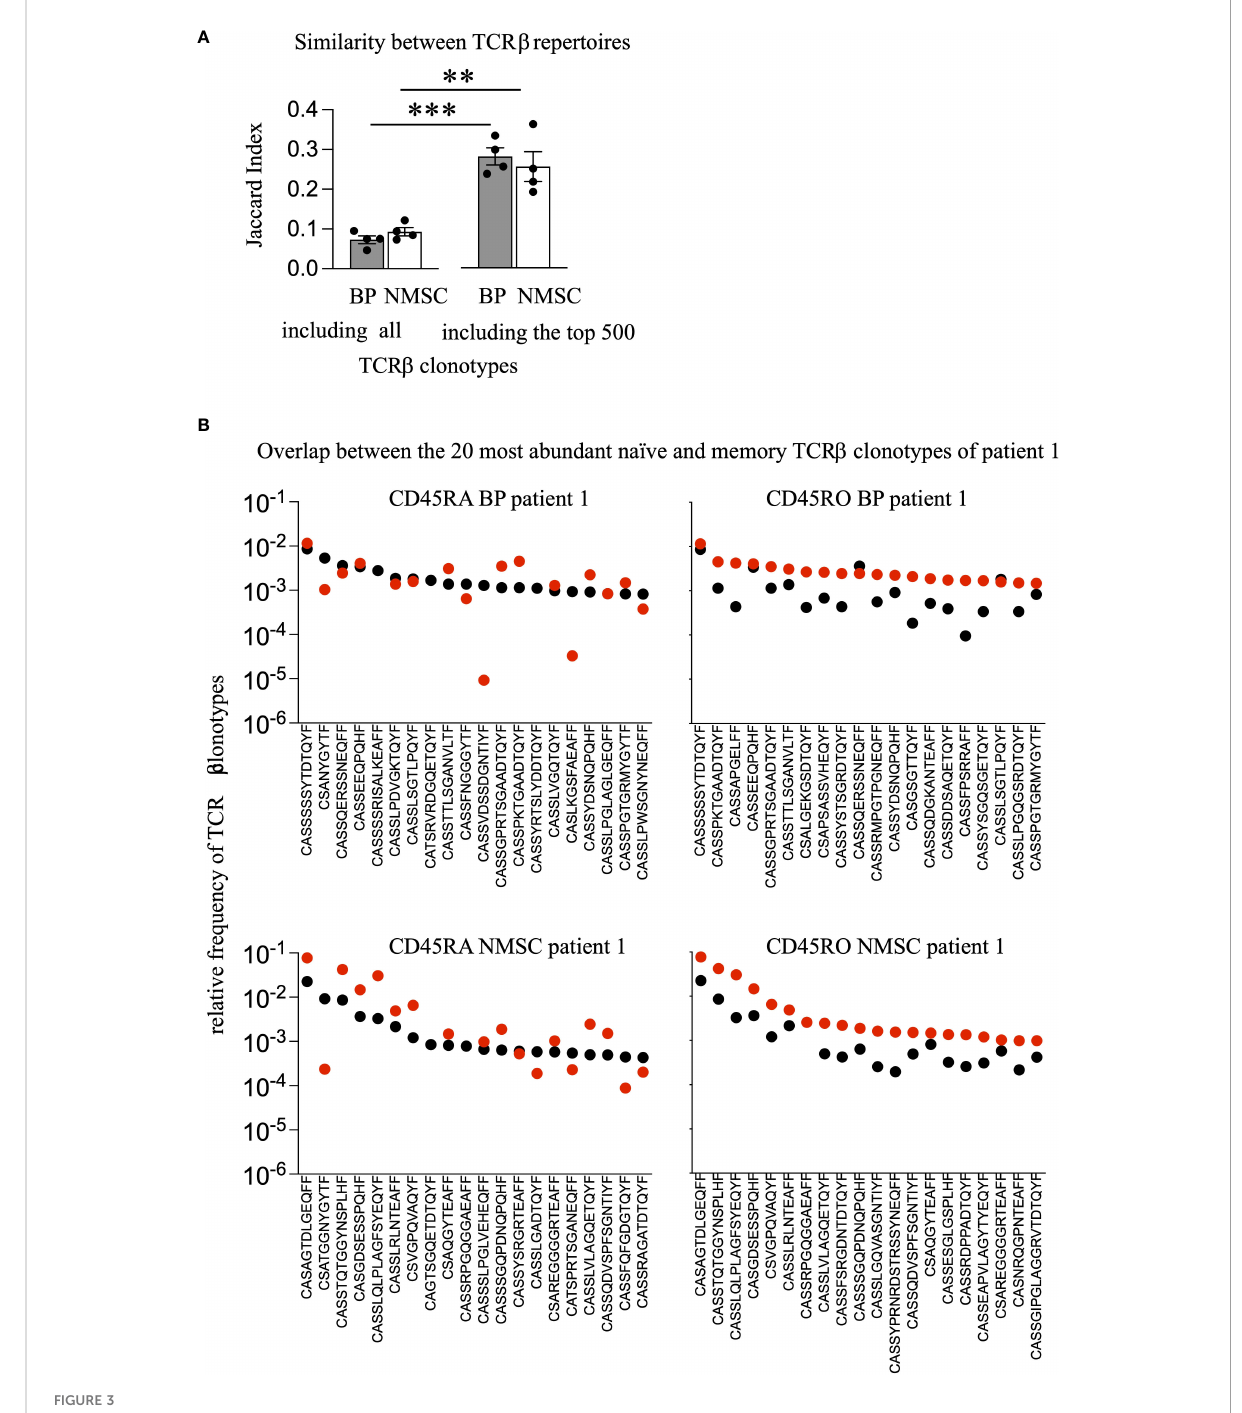
FIGURE 3 No difference in the degree of overlapping TCR b clonotypes between BP and NMSC patients. (A) To assess the portion of overlapping TCR b clonotypes between the CD45RO and CD45RA populations within each patient quantitatively, the Jaccard Index was calculated by either including all TCR b clonotypes or including only the top 500 most abundant TCR b clonotypes. (Data are mean ± SEM, ***p < 0.001, **p < 0.01, 2-way ANOVA with turkeys ’ multiple comparison test). (B) The 20 most frequent TCR b clonotypes present in the CD45RO population (black dots, left panel) are compared to their presence in the CD45RA population (red dots, left panel) and vice versa, the 20 most frequent TCR b clonotypes present in the CD45RA population (black dots, right panel) are compared to their presence in the CD45RO population (red dots, right panel) within BP patient 1 (upper panel) or NMSC patient 1 (lower panel). One representative comparison out of all patients is